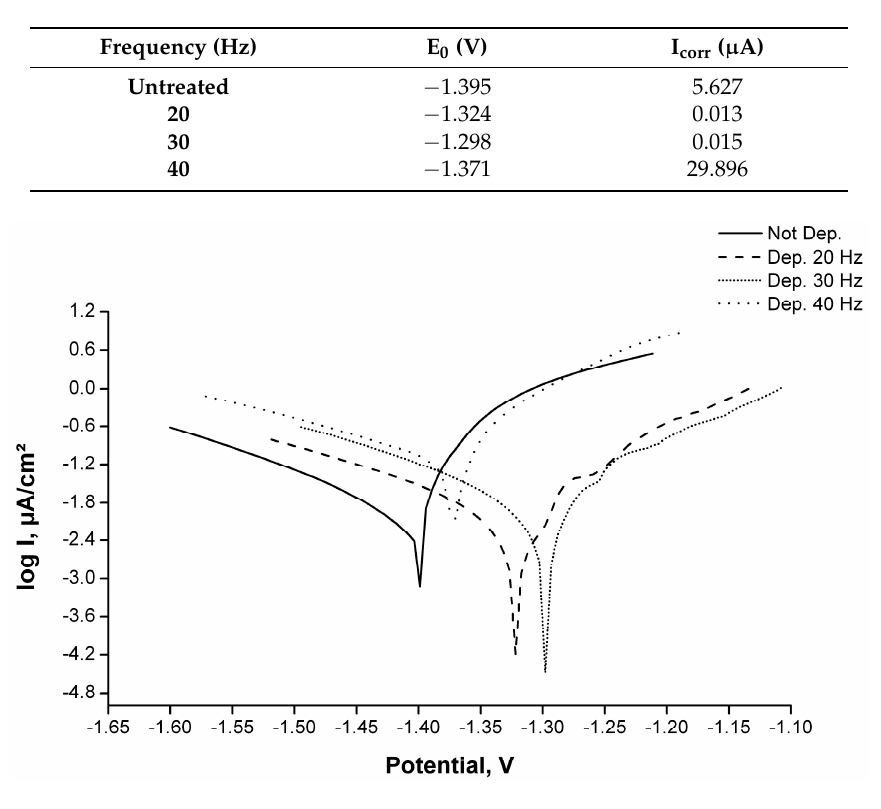
Figure 16. Tafel curves of coated samples.